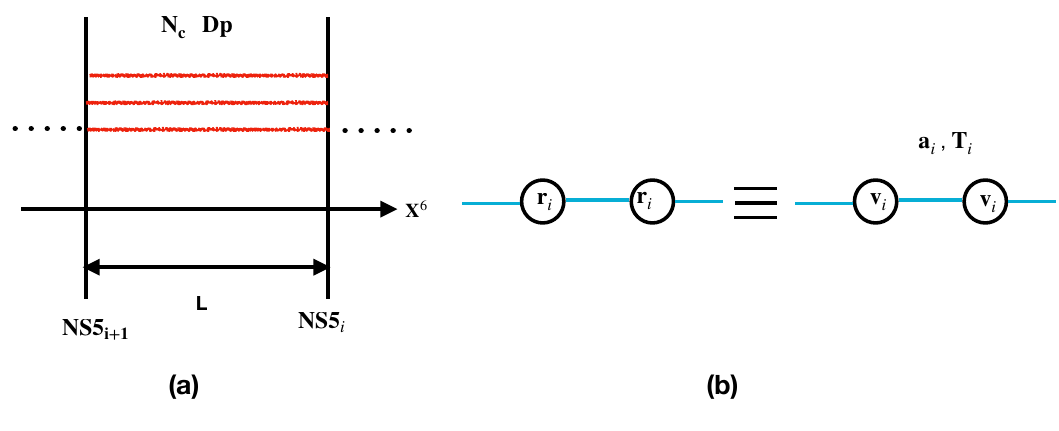
Figure 3 . (a) Two NS5 branes (located at i and i + 1 along the X 6 direction) are separated due to N color Dp branes placed in between, (b) Different vector multiplets ( V c link which is built out of tensor multiplets ( T